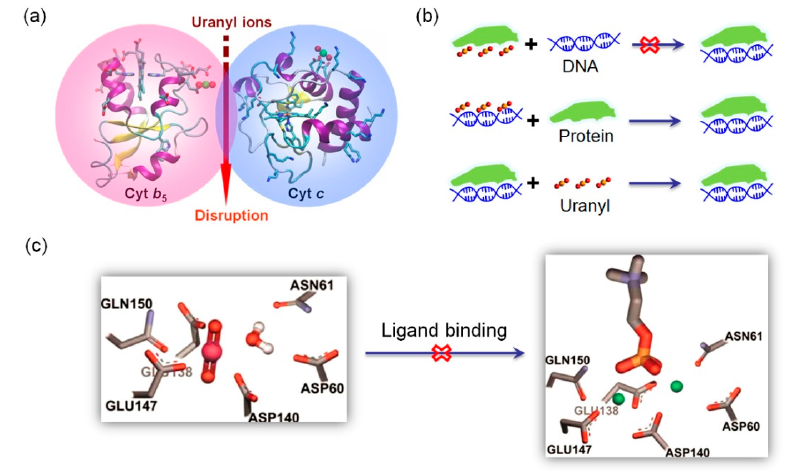
Figure 6. Uranyl-induced disruption of protein-protein / DNA / ligand interactions. ( a ) A schematic presentation of the disruption of Cyt b 5 -Cyt c interactions by uranyl ions, adapted from [45]. ( b ) A schematic presentation of uranyl inhibition of DNA binding to proteins and control studies [84]. ( c ) A predicted model of uranyl binding to the Ca 2 + -binding site in C-reactive protein (CRP) (left), which inhibits the binding of Ca 2 + ions and the ligand, phosphorylcholine, as shown in an X-ray crystal structure (PDB code 1B09) (right). Reprinted with permission from Ref. [87], Copyright 2010, The Protein